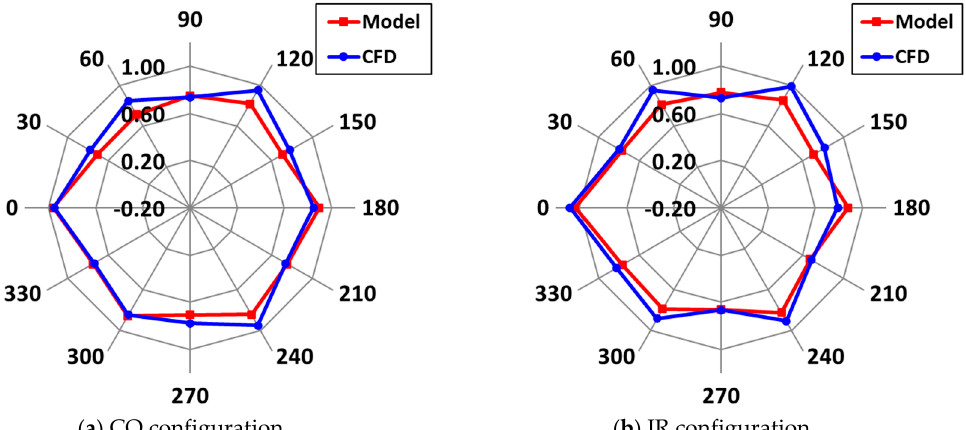
Figure 18. Distributions of averaged rotor power of three rotors in the configurations: ( a ) CO-rotation (CO); ( b ) inverse rotation (IR). The power is normalized by the single rotor power. Red symbols show the results of model simulation and blue symbols show CFD analysis (reproduced with permission from Okinaga et al. [41]). The inter-rotor space ( gap ) is 1.0 D .